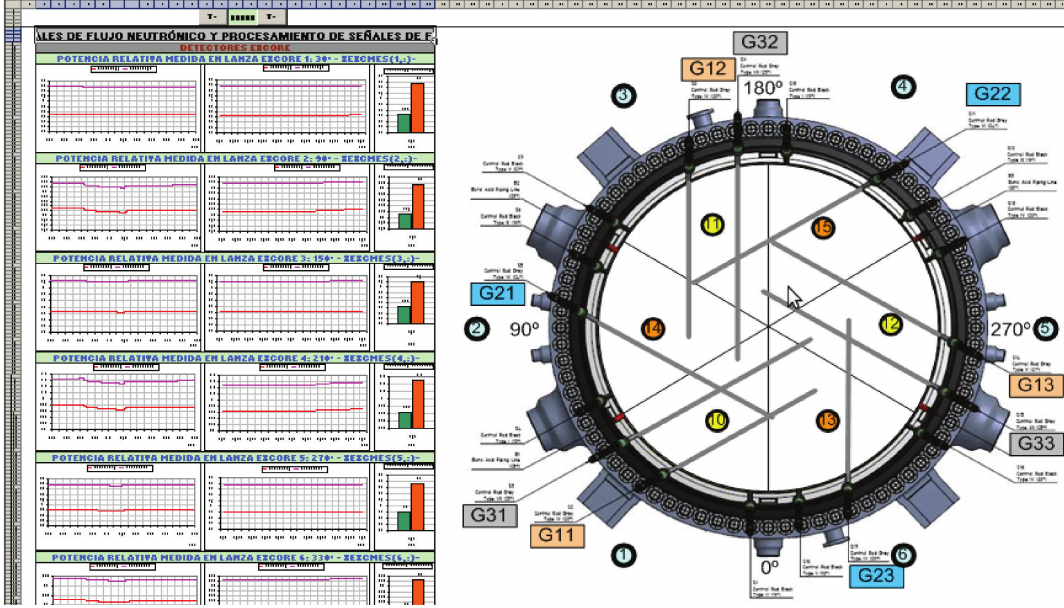
Figure 15: Postprocessing spreadsheet. In-core SPN detectors readings and control rod positions to aid in the back-tracking of the azimuthal power distribution control